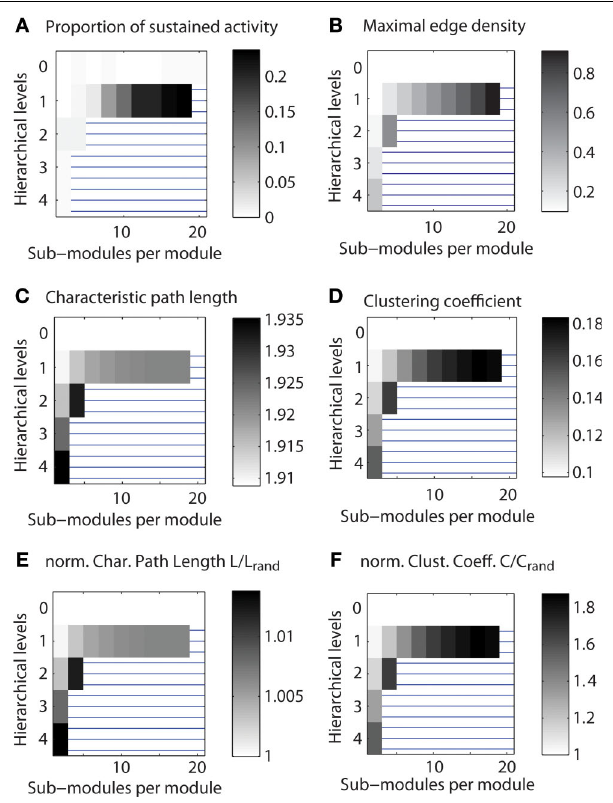
FIGURE 4 | Range of limited sustained activity for different hierarchical confi gurations of a small network. Shown is the parameter range of limited sustained activation and of topological features for a network with 512 nodes and average node degree of 50. Regions blocked by horizontal lines indicate confi gurations that were not admissible (see Materials and Methods). Parameters were explored for 1,000 runs of each set of spreading parameters k and v , while the number of initially activated nodes i and the localization parameter i varied for each run. (A) Average of the number of parameter 0 settings leading to LSA. (B) Maximum edge density based on the most highly connected modules (modules at the lowest level of the respective hierarchy). (C) Characteristic path length of the networks. (D) Average clustering coeffi cient of the networks. (E) Normalized characteristic path length (divided by the value for Erdös–Rényi random networks). (F) Normalized average clustering coeffi cient (divided by the value for Erdös–Rényi random